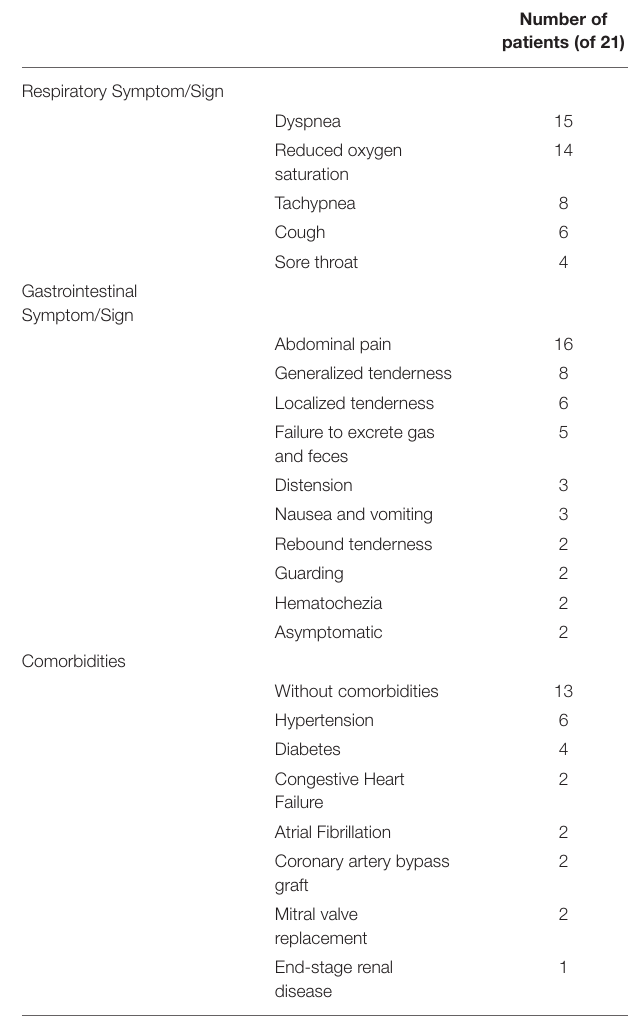
TABLE 2 | Distribution of the characteristics of the